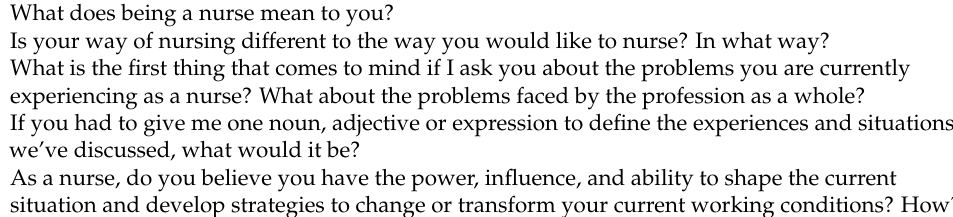
Table 2. The script for the semi-structured interview for clinical nurses. What does being a nurse mean to